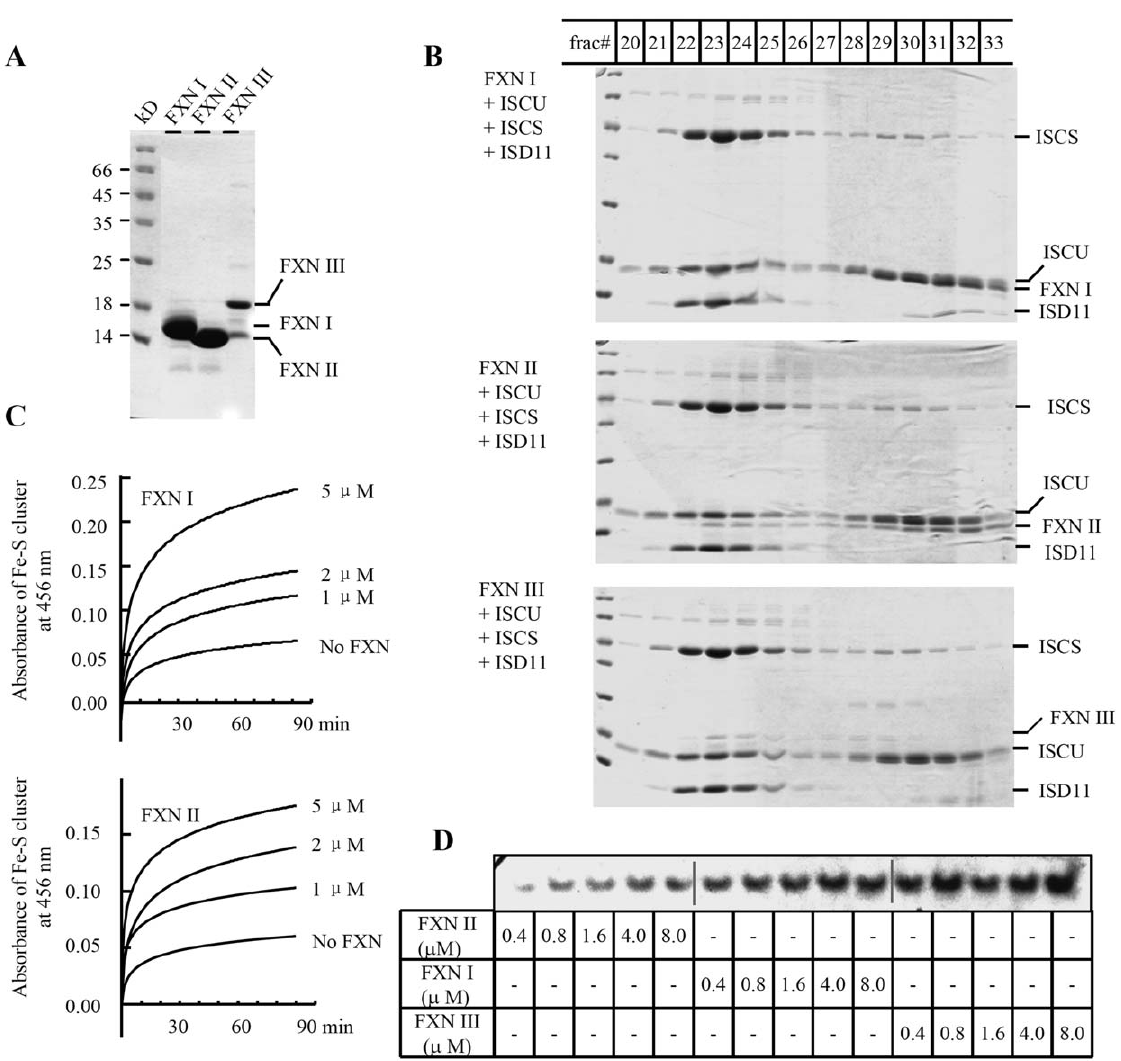
Figure 4. Functional human FXN isoforms facilitating Fe-S cluster assembly invitro . ( A ) FXN isoforms were expressed in E. coli and purified to run a SDS-PAGE gel, followed by Coomassie staining. ( B ) Each of the three FXN isoforms could form a complex with other three essential components (ISCS/ISD11, ISCU) of Fe-S cluster assembly in vitro . Purified proteins FXN, ISCU, and ISCS/ISD11 were mixed and incubated for 1 hour anaerobically, and then subjected to size exclusion column. The collected fractions were run in SDS-PAGE gels as shown here. ( C ) Fe-S cluster assembly profile at 456 nm within 90 min. ( D ) In-gel aconitase assay of IRP1 after incubation of apo-IRP1 with assembled Fe-S cluster by the complex of four components including FXN, ISCS/ISD11, and